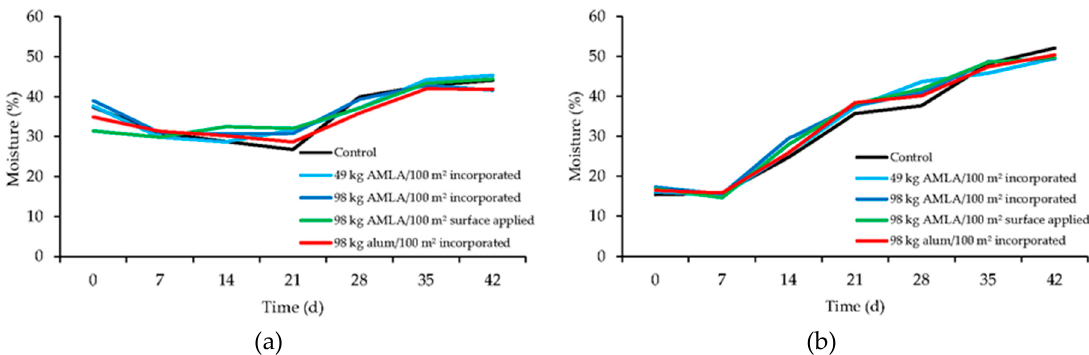
Figure 2. Litter moistures for ( a ) flock 2 and ( b ) flock 3 as a function of time.